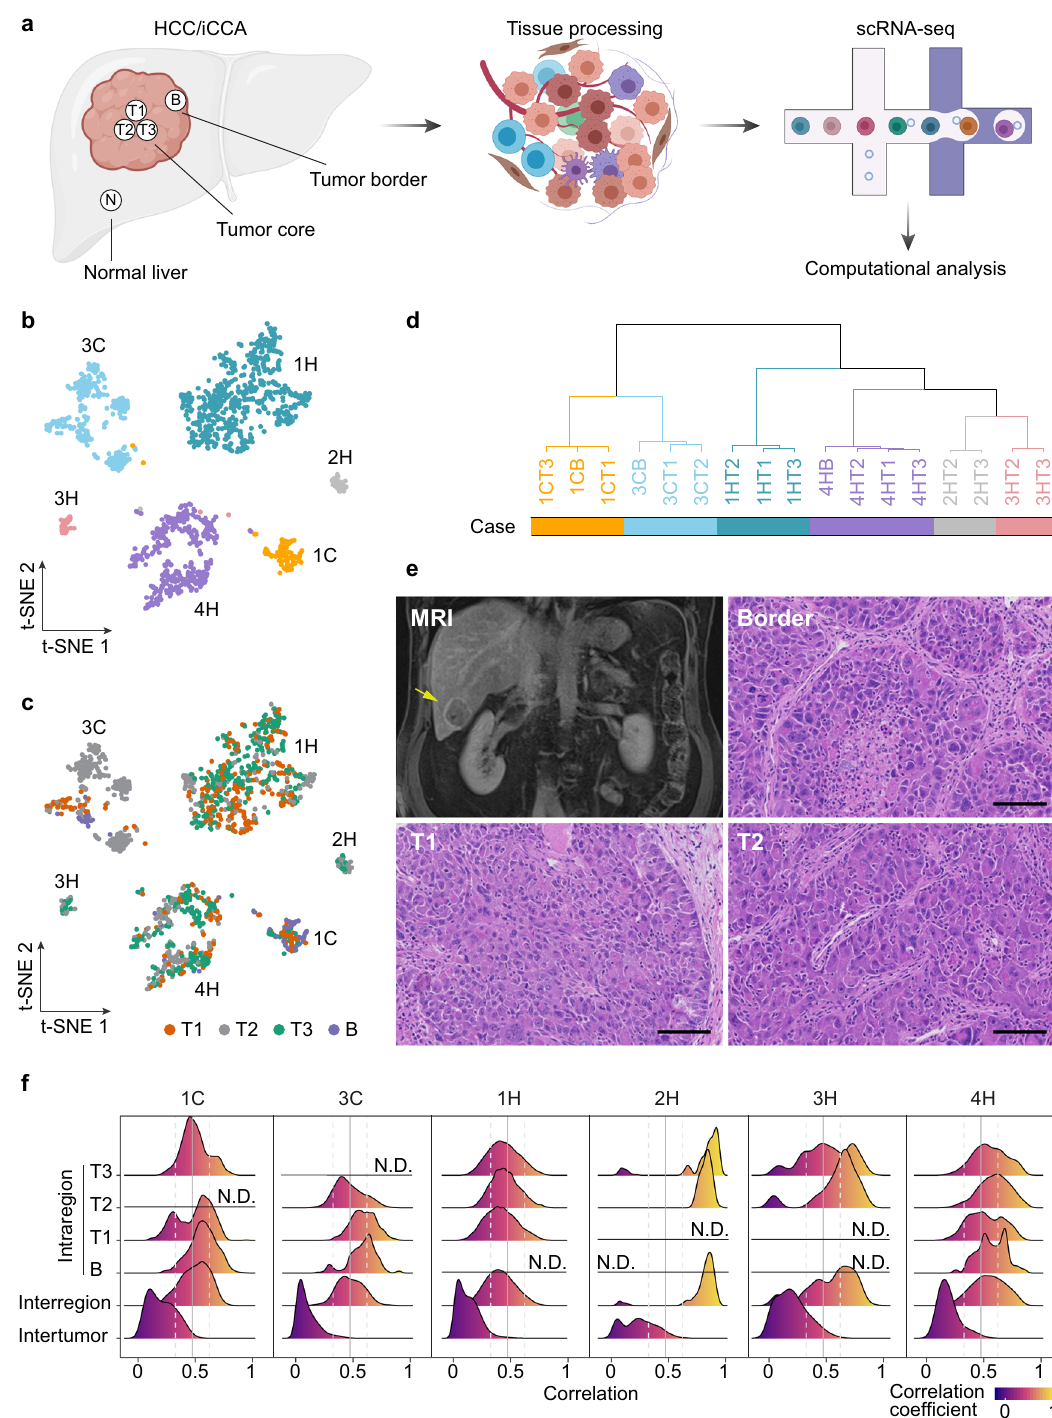
Fig. 1 | Multiregional single-cell transcriptome pro fi ling of liver